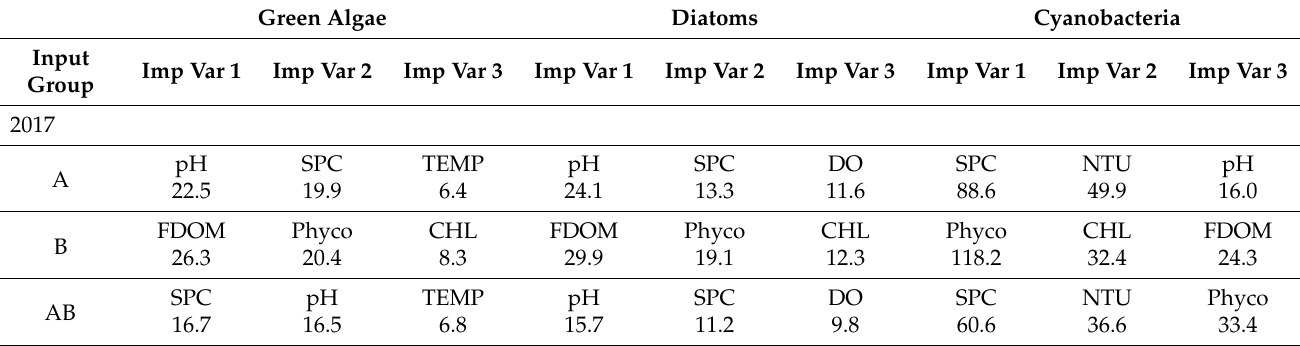
Table 4. Most influential predictors and increase in mean square error for that variable for Pond 2 as determined using the random forest